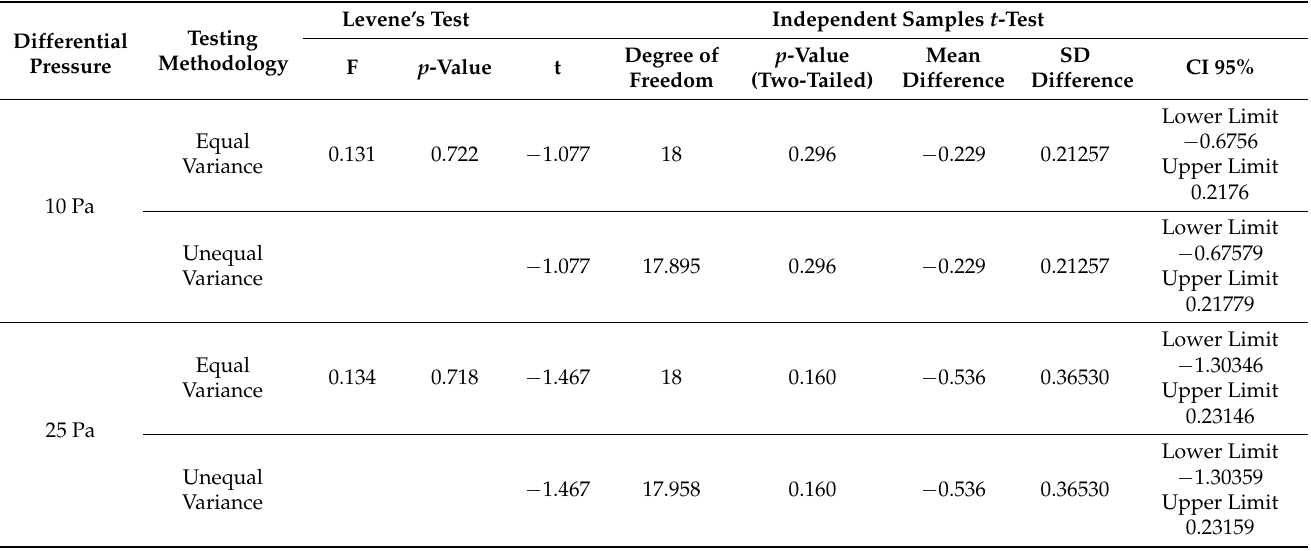
Table 2. Independent sample